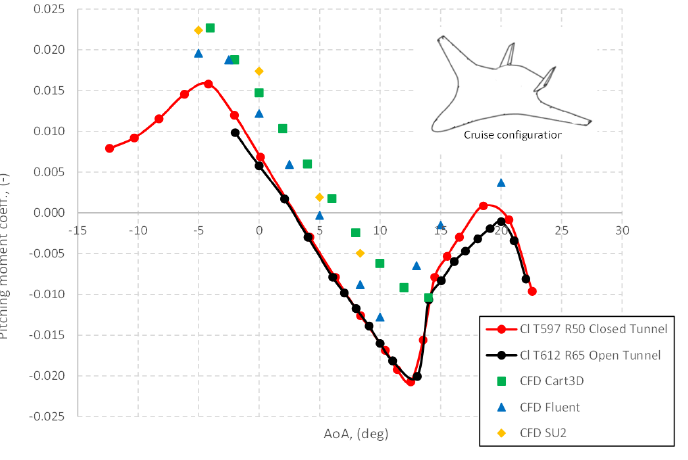
Figure 15. Pitching moment coefficient. Comparison between present results and literature data